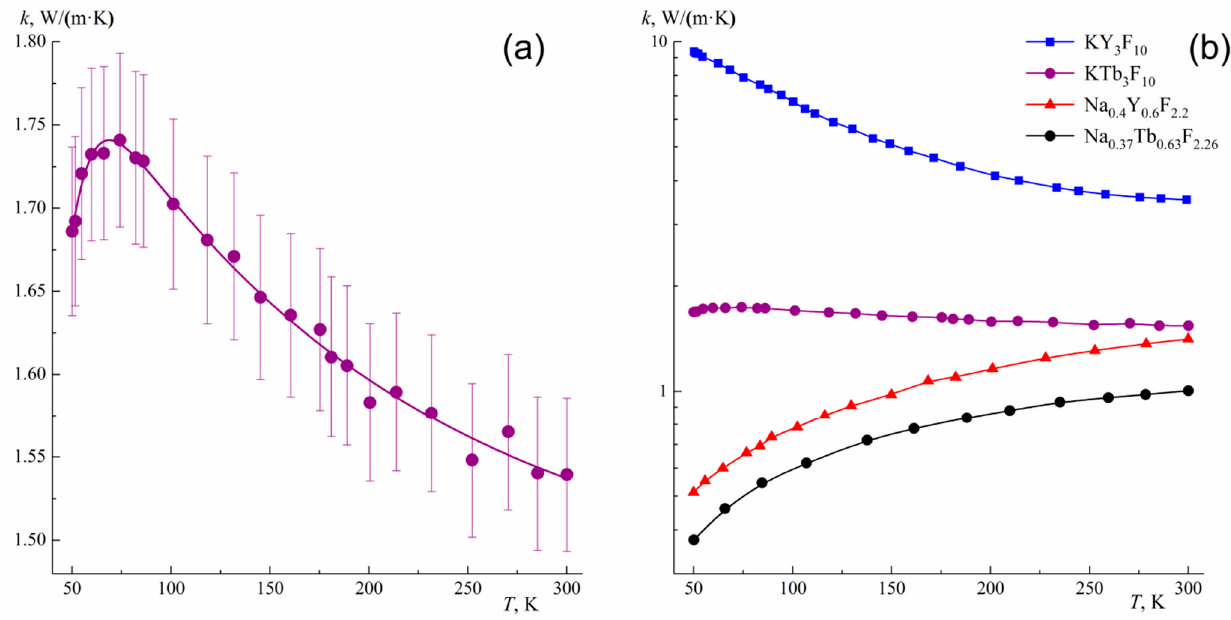
Figure 9. Temperature dependence of the thermal conductivity k ( T ) of KTb 3 F 10 crystal ( a ) and comparative data on the k ( T ) for KF- and NaF-based crystals ( b ). The vertical frames correspond to the reproducibility limits of experimental results within ±3% for the possibility of the tracking temperature trend.